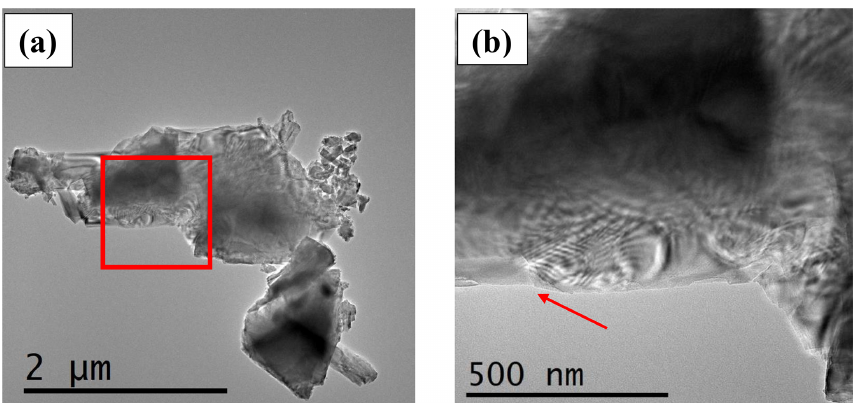
Figure 11. (a) Bright-field (BF) TEM image showing diffraction fringes on a glaucophane particle. The red square represents the area shown in panel (b) . (b) Magnified image of the area with diffraction contrast that is generated by the presence by slightly misoriented lamellae. A step in the grain-boundary area is visible (red